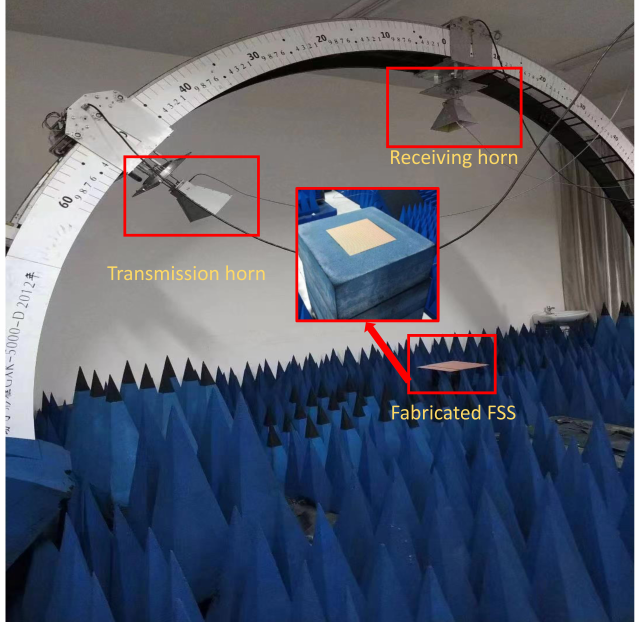
Figure 10. The arch measurement setup of the fabricated FSS. The transmission and receiving horns are mounted on an arc perpendicular to the plane of the fabricated